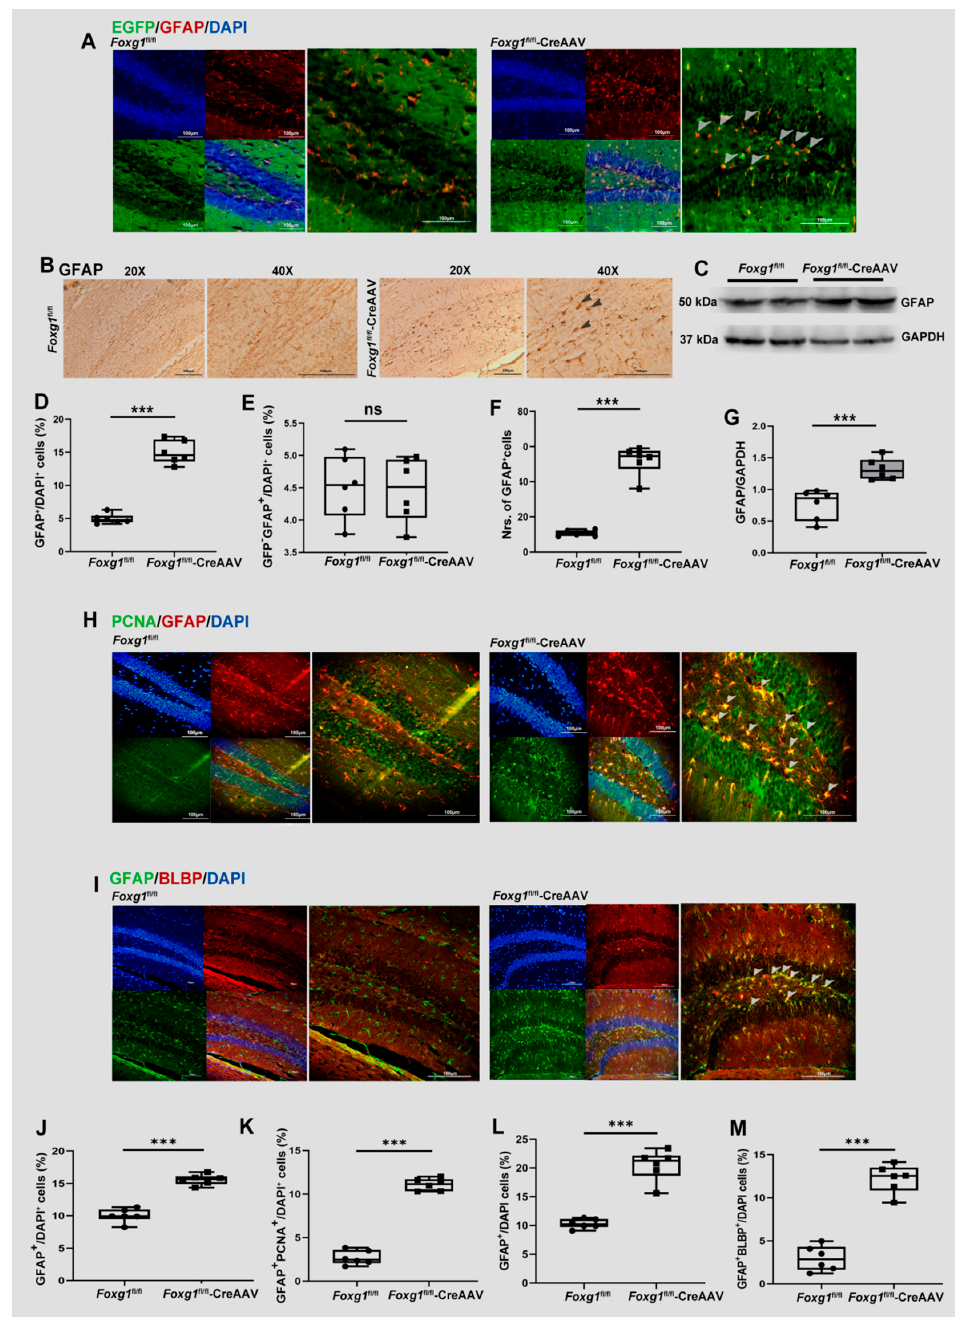
Figure 2. FOXG1 increases the amount of neuronal stem cells (aNSCs) in adult hippocampal DG of the Foxg1 genotype mice and promotes qNSCs giving rise to activated aNSCs. ( A ) Expression patterns of GFAP-expressing qNSCs in the hippocampal DG of Foxg1 genotype mice were assessed with immunofluorescence. Red = GFAP; Green = EGFP-labeled FOXG1; Blue = DAPI. Scale bars = 100 µ m. Arrow heads: newly generated qNSCs with FOXG1 activation. ( D ) Levels of total qNSCs in adult hippocampus are showed as %GFAP + /DAPI + cells. ( E ) Levels of endogenous qNSCs in adult hippocampus are showed as %GFP - GFAP + /DAPI + cells. ( B ) Expression patterns and ( F ) qualification of total qNSCs in adult hippocampus were studied with immunohischemisitry using an antibody against GFAP. Scale bars = 100 μ m. ( C ) Hippocampal lysates of the two genotype mice were immunoblotted using an antibody against GFAP. ( G ) Qualification of GFAP expression is illustrated by bar graph. GAPDH was used as the loading control. ( H ) Expression patterns of proliferated qNSCs